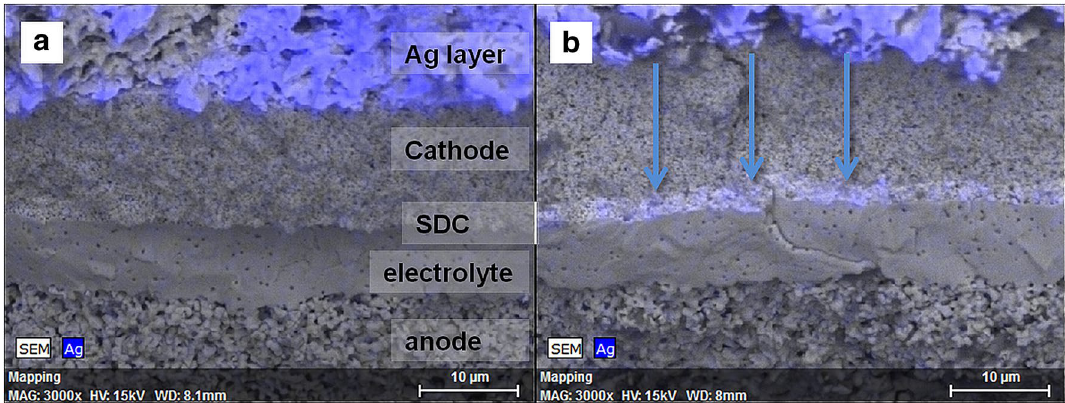
Fig. 8 SEM micrographs of the cell after 48 h operation at 700 °C: a the cross-section of the cell 2 cm from the CPOX catalyst; b the cross- section of the part of the cell near the